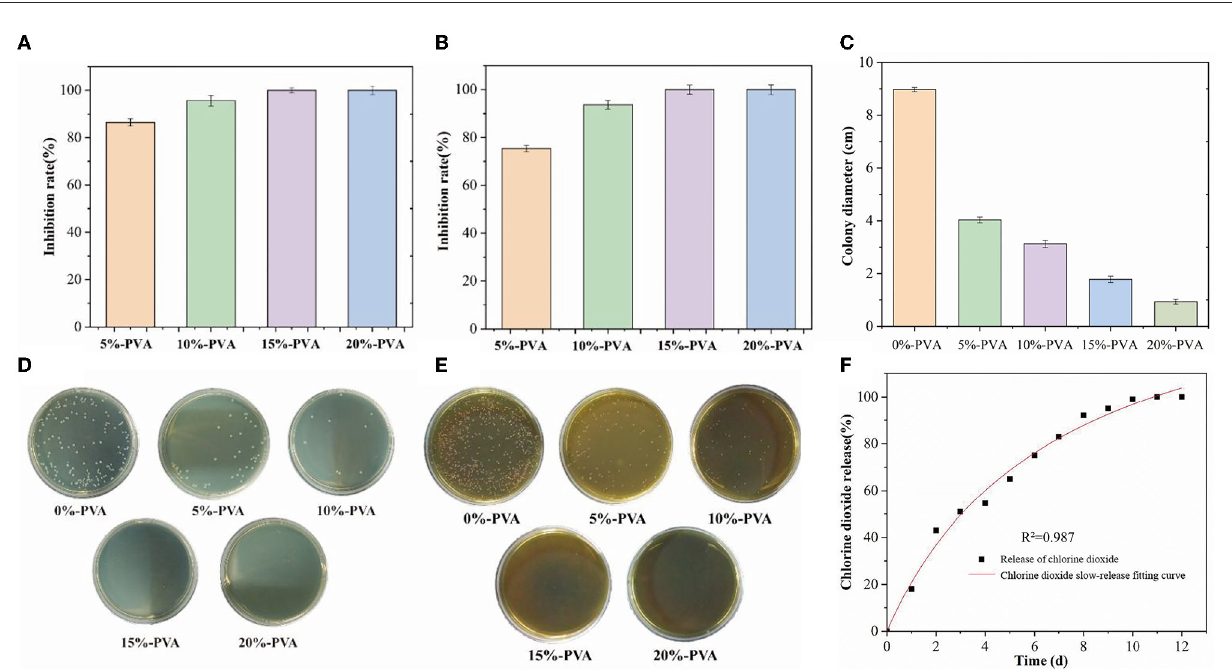
FIGURE3 Bacteriostatic effect of PVA films with different microcapsule contents on Escherichia coli and Listeria , (A, D) are Escherichia coli, and (B) and (E) are Listeria . Bacteriostatic effect of PVA film with different microcapsule contents on the mold (C) , and logistic release model fitting of the antimicrobial film (F) . PVA, polyvinyl